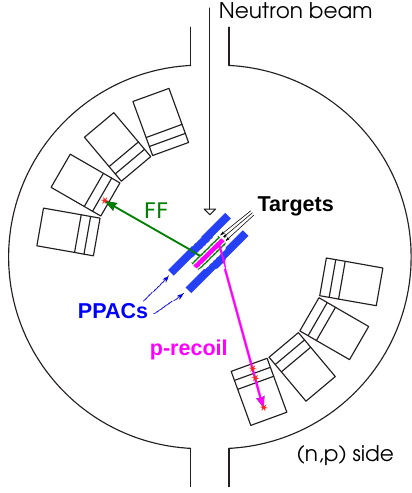
Figure 1. A layout of the upgraded Medley setup for (n,f) cross section measurements with respect to n-p elastic scattering. The fission fragments will be detected by one of the PPACs and stopped in the first Si detector in one of the eight telescopes. The proton recoil from H(n,p) will be stopped in the CsI(Tl) scintil- lator in one of the front telescopes, because of the kinematics of the reaction